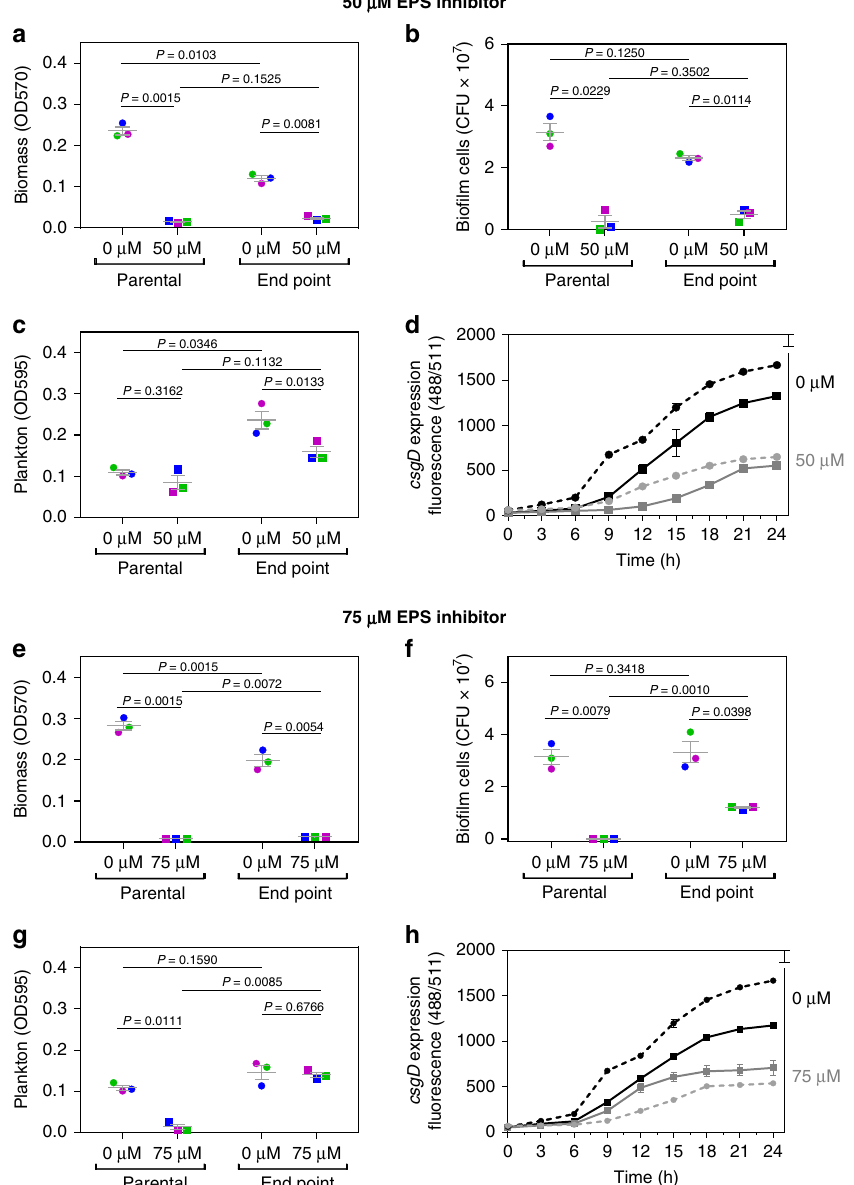
Fig. 3 Resistance to EPS inhibition does not evolve over 40 days. Effect of 50 µ M EPS inhibitor on a biomass, b number of bio fi lm cells, and c plankton in well-shaken tubes of parental wild-type strain ATCC14028 and evolved end point populations. d csgD expression of parental (dashed line) and end point (full line) bio fi lm strains in function of time in absence and presence of 50 µ M EPS inhibitor. || Effect of 75 µ M EPS inhibitor on e biomass, f number of bio fi lm cells, and g plankton in well-shaken tubes of parental wild type strain ATCC14028 and evolved end point populations. h csgD expression of parental (dashed line) and end point (full line) bio fi lm strains in function of time in absence and presence of 75 µ M inhibitor. Lines represent mean, dots represent measurements for three parallel evolved populations and error bars show s.e.m ( n = 3 parallel evolution experiments, started from three biologically independent samples). Exceptions are Figures d and h , which show results for one evolution experiment (one clone isolated from the parental and end point population; tested in three technical repeats), representative for the three parallel evolution experiments. P values derived from two-tailed paired student ’ s t test. Source data are provided as a Source Data fi